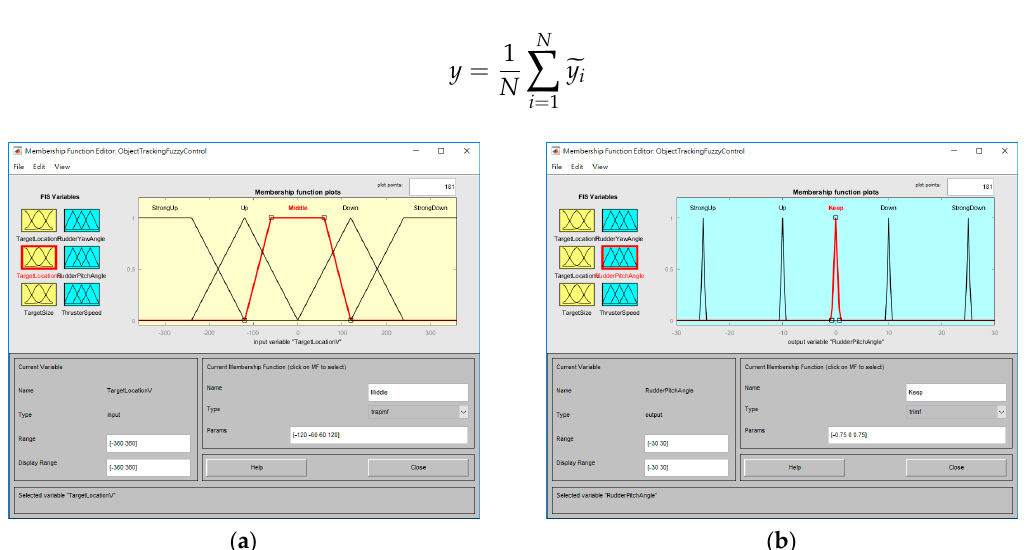
Figure 8. Interfaces of ( a ) the input variable of membership of the object on the visual plane (Y-direction) and ( b ) the output variable of membership of the vertical rudder angle.